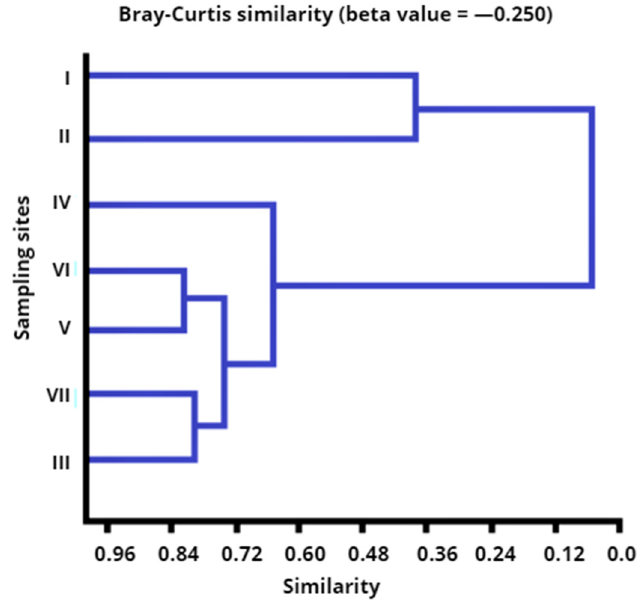
Figure 3. Similarities between sampling sites based on the counts of opportunistic pathogens P. P. fluorescens (OPPF) responding to di ff erent minimum inhibitory concentrations of cefotaxime (MIC fluorescens (OPPF) responding to different minimum inhibitory concentrations of cefotaxime (MIC